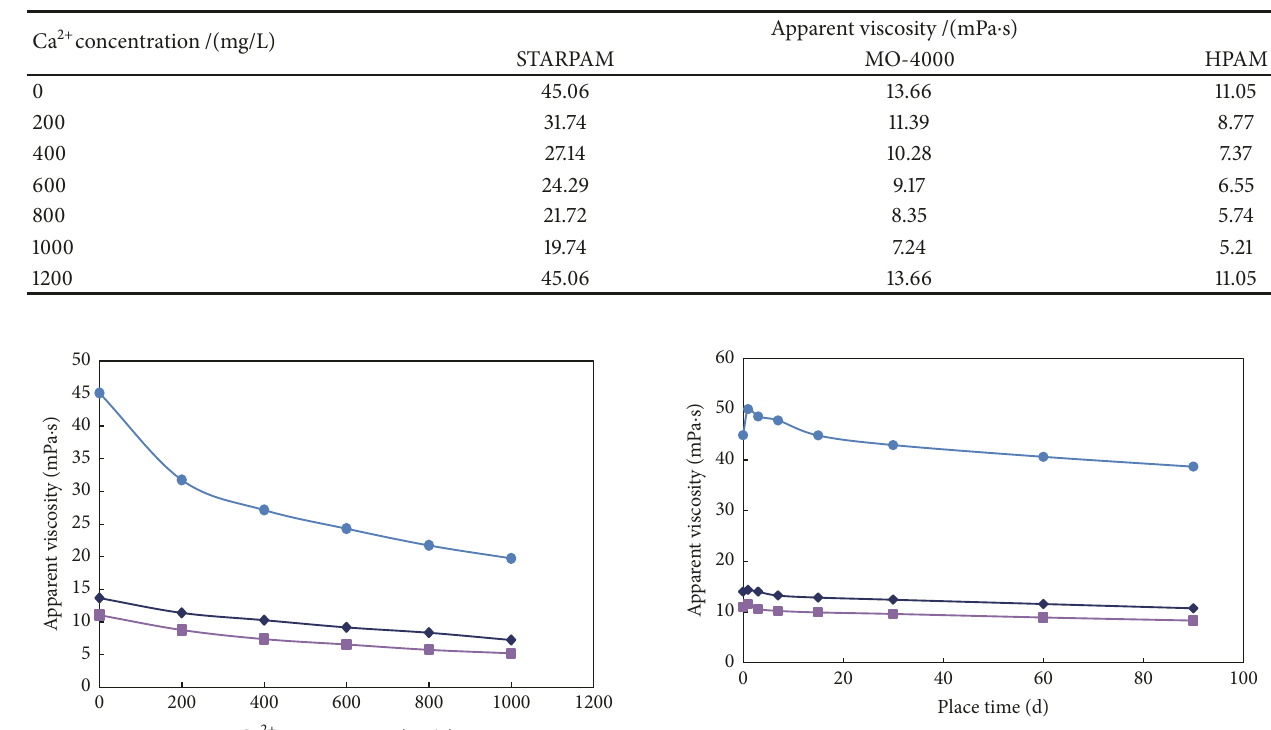
Table 5: Comparison of the influence of polymers viscosity on the Ca 2+ .